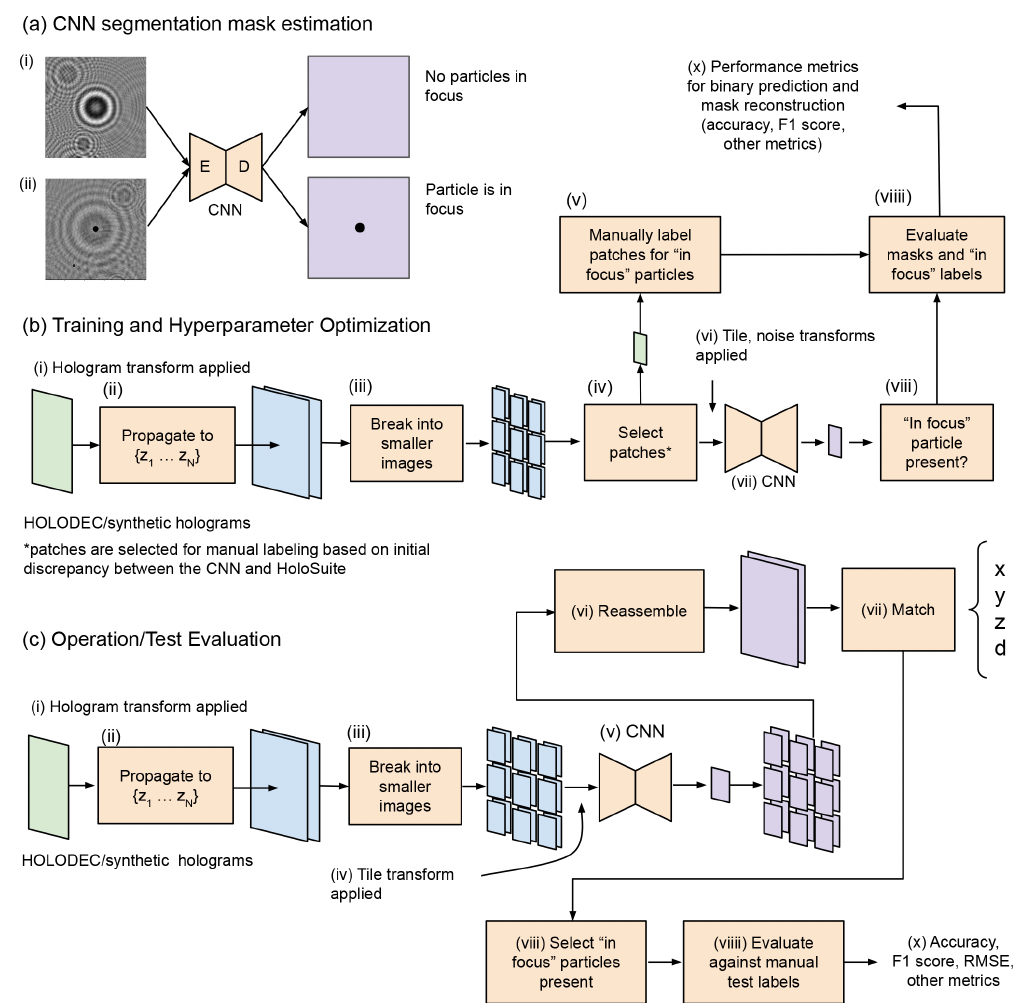
Figure 3. (a) Two input examples to a neural segmentation model are shown. The segmentation model is illustrated as having encoder– decoder architecture, such as a U-net. (i) The image does not contain an in-focus particle as no mask was predicted. In (ii) the model predicted a mask around an in-focus particle. Illustrations of (b) the training and hyperparameter optimization workflow and (c) the testing/operational workflow for processing